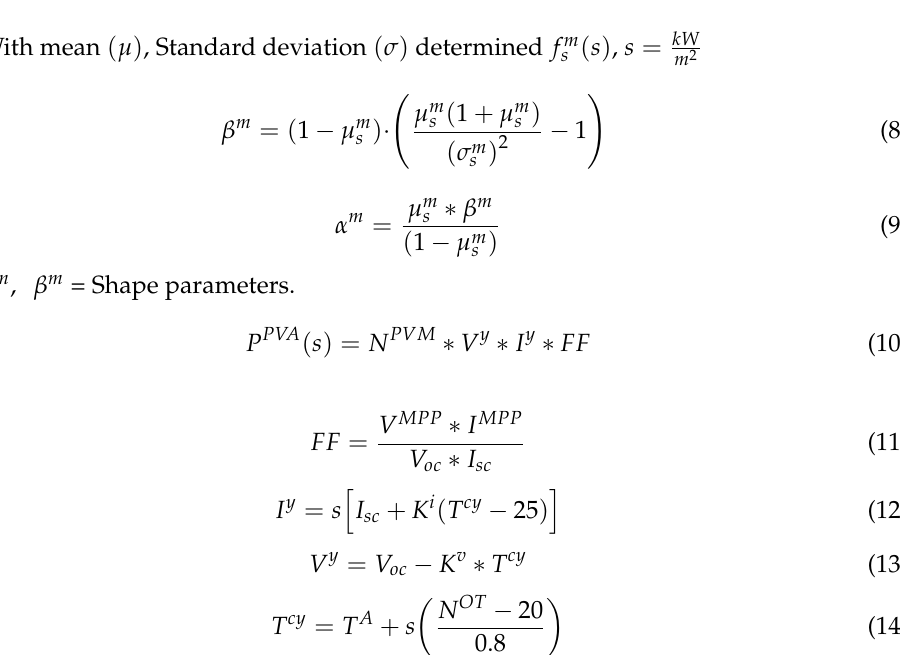
FF = fill factor, the sum of all PV modules = 𝑁 𝑃𝑉𝑀 , 𝐼 𝑠𝑐 = short circuit current, 𝑉 𝑜𝑐 = open-circuit voltage, 𝑇 𝑐𝑦 = cell temperature, 𝑇 𝐴 = ambient temperature, 𝐾 𝑖 , 𝐾 𝑣 = current and voltage temperature coefficients, 𝑁 𝑂𝑇 = nominal operating temperature.